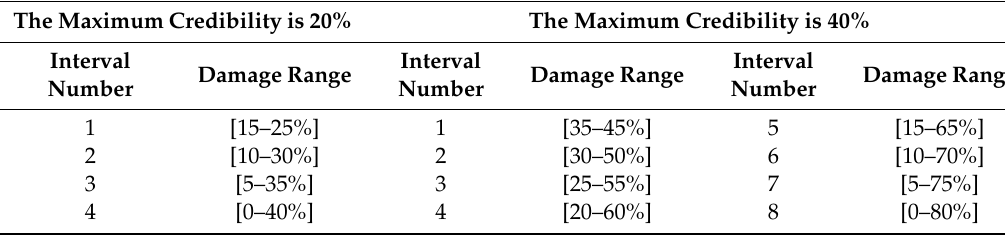
Table 1. Division of damage degree interval.